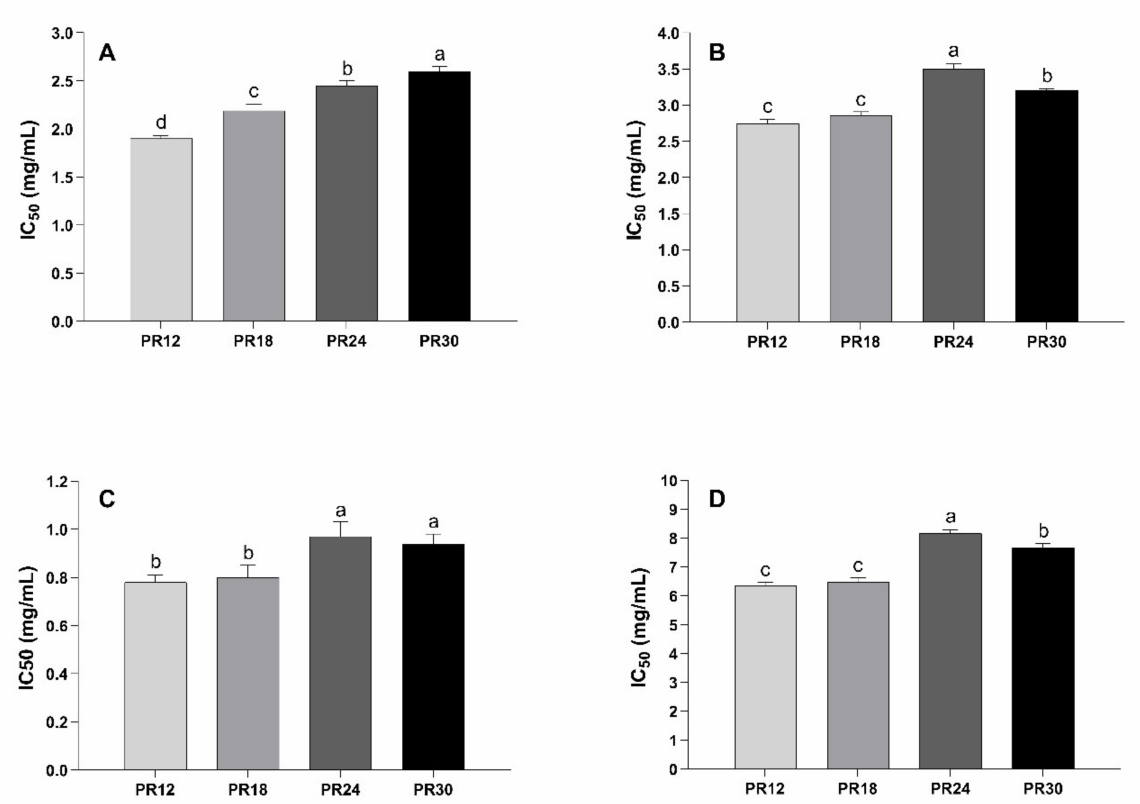
Figure 2. Effect of Parmigiano-Reggiano (PR) water-soluble peptide extracts on the activity of key metabolic enzymes and on advanced glycation end-products formation. ( A ) Inhibition of a-amylase activity. ( B ) Inhibition of a-glucosidase activity. ( C ) Inhibition of dipeptidyl peptidase IV activity. ( D ) Inhibition of fluorescent advanced glycation end-products formation. Water-soluble peptide extracts represent the peptidic fractions obtained after ultrafiltration (<3 kDa) of water-soluble peptides extracted from PR samples. PR12: Parmigiano-Reggiano at 12 months of ripening. PR18: Parmigiano-Reggiano at 18 months of ripening. PR24: Parmigiano-Reggiano at 24 months of ripening. PR30: Parmigiano-Reggiano at 30 months of ripening. Results were expressed as IC 50 , namely the peptides concentration (expressed in mg/mL) able to inhibit the enzymatic activity or the advanced glycation end-product formation by 50%. The IC 50 values were calculated by plotting the peptide concentration (base-10 logarithm) as a function of the percentage of inhibition. Values are means of three independent digestions ± standard deviation (SD). Different letters indicate significantly different values ( p <